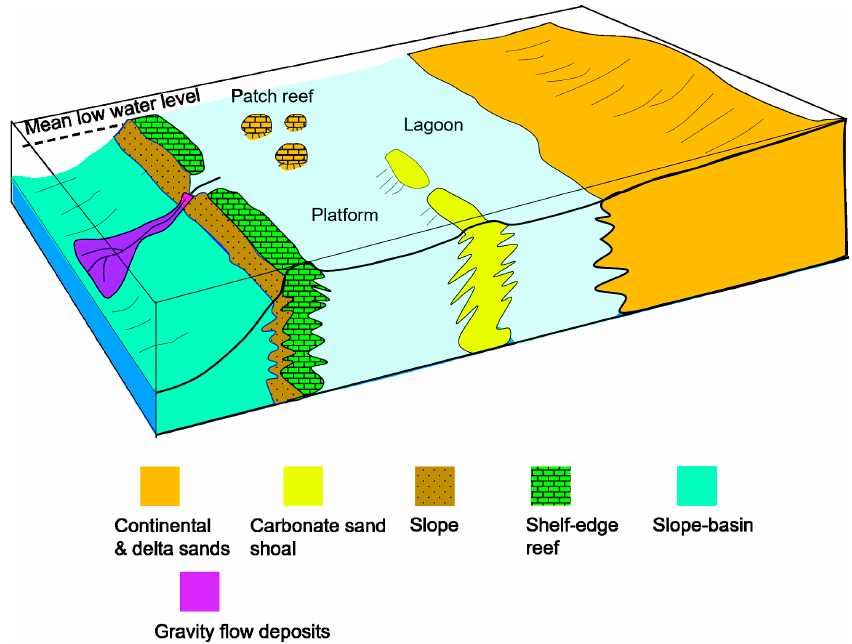
Figure 23. Schematic diagram showing carbonate deposition on shelf, along shelf edge, slope, and in basin environments.